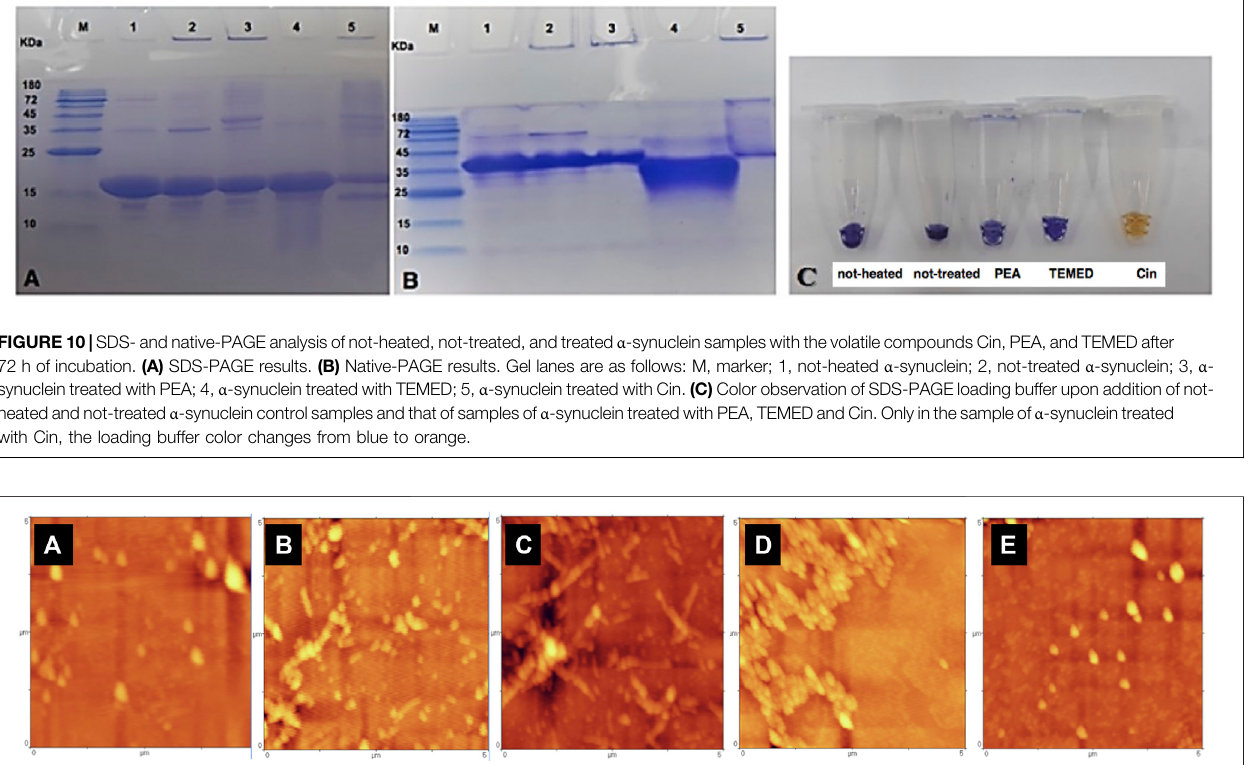
FIGURE 11 | AFM result of α -synuclein control samples and samples treated with the volatile compounds Cin, PEA, and TEMED after 72 h of incubation. (A) Not- heated α -synuclein; (B) not-treated α -synuclein; (C) α -synuclein treated with PEA; (D) α -synuclein treated with TEMED; (E) α -synuclein treated with Cin.